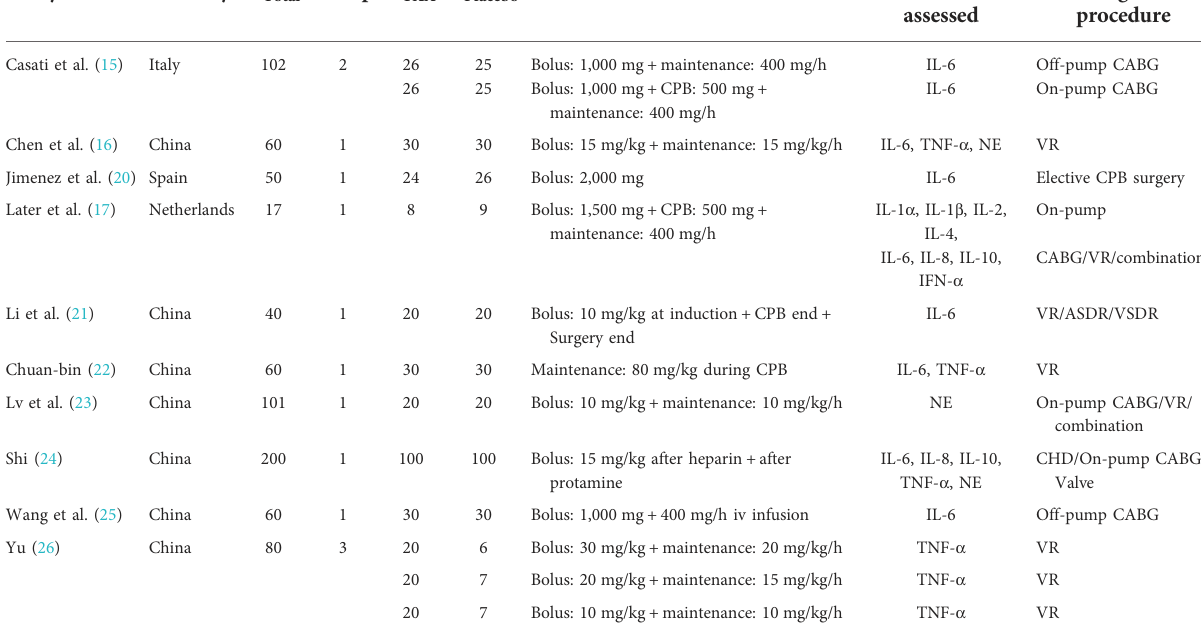
TABLE 1 Characteristics of the included trials.